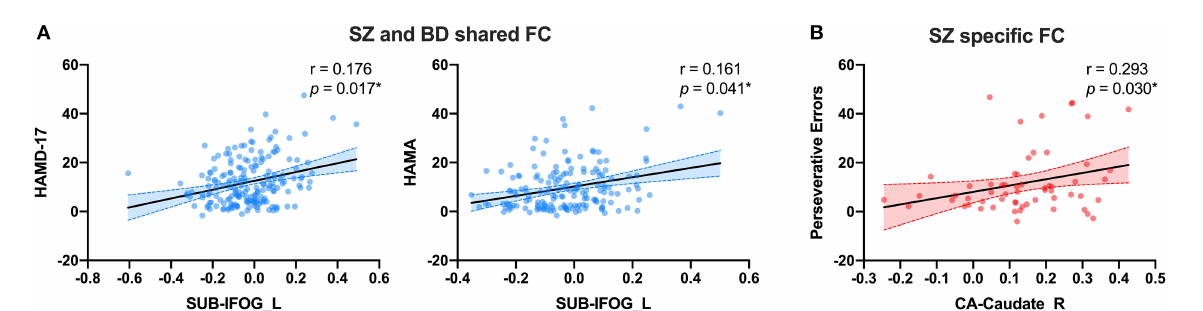
FIGURE5 The partial correlation results of shared or distinct altered FC with clinical characteristics. (A) The partial correlation between SUB-MTG_L and HAMD-17 and HAMA in SZ and BD groups. (B) The partial correlation between CA-Caudate_R and preservative errors of WCST in SZ group. FC, Functional Connectivity; CA, Cornu Ammonis; SUB, Subiculum; SZ, Schizophrenia; BD, Bipolar Disorder; MDD, Major Depressive Disorder; HAMD-17, 17-item Hamilton Rating Scale for Depression; HAMA, Hamilton Rating Scale for Anxiety; IFOG_L, Left Inferior Orbital Frontal Gyrus; Caudate_R, Right Caudate. All the scattered points were controlled by age, gender, years of education and mean FD. *Significance was set at p <